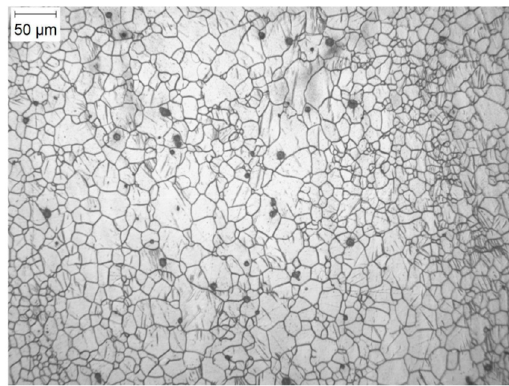
Figure 11. Original microstructure of the magnesium alloy AZ31.